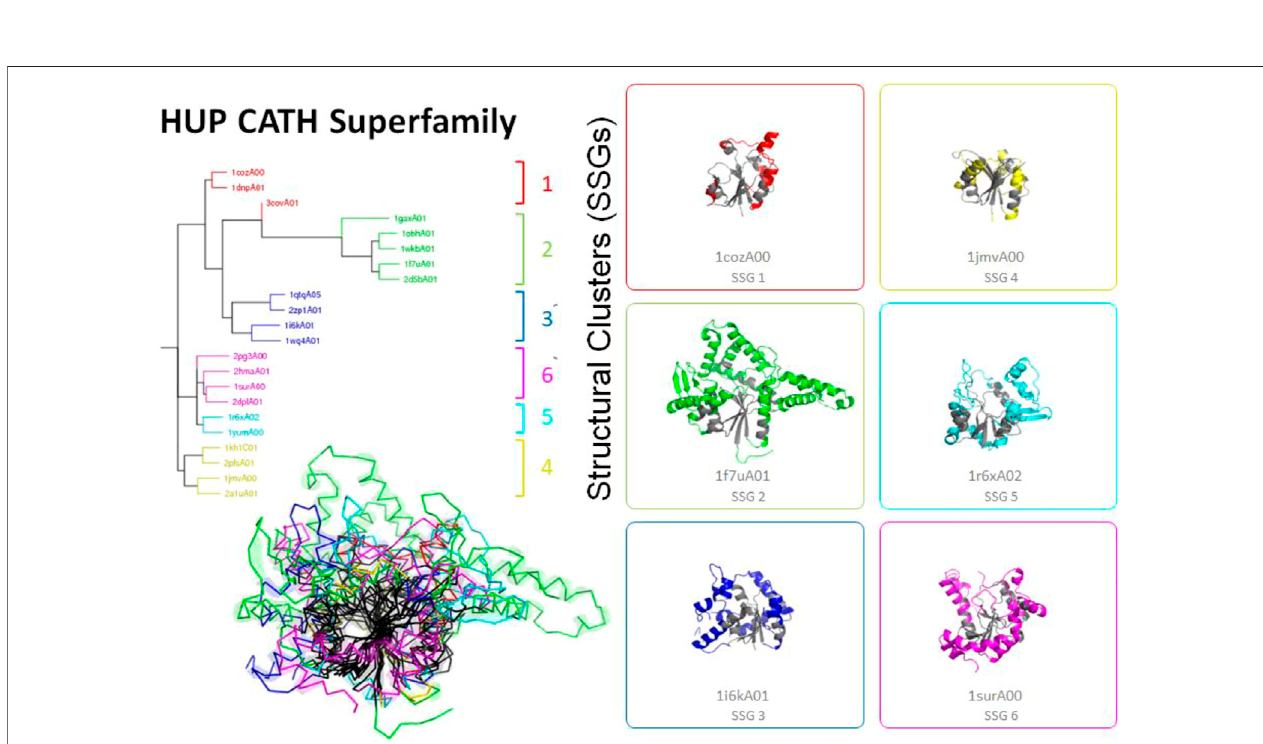
FIGURE 4 | Highly divergent structural homologues within the HUPs SuperFamily (CATH ID 3.40.50.620). Six diverse structural clusters (also called structurally similar groups, SSGs) are identi fi ed using SSAP to compare structures all against all (see tree top left and fi gures on the right). However, representatives from each SSG can be superposed to reveal the highly conserved structural core common to all (see central black region in the bottom left fi gure).